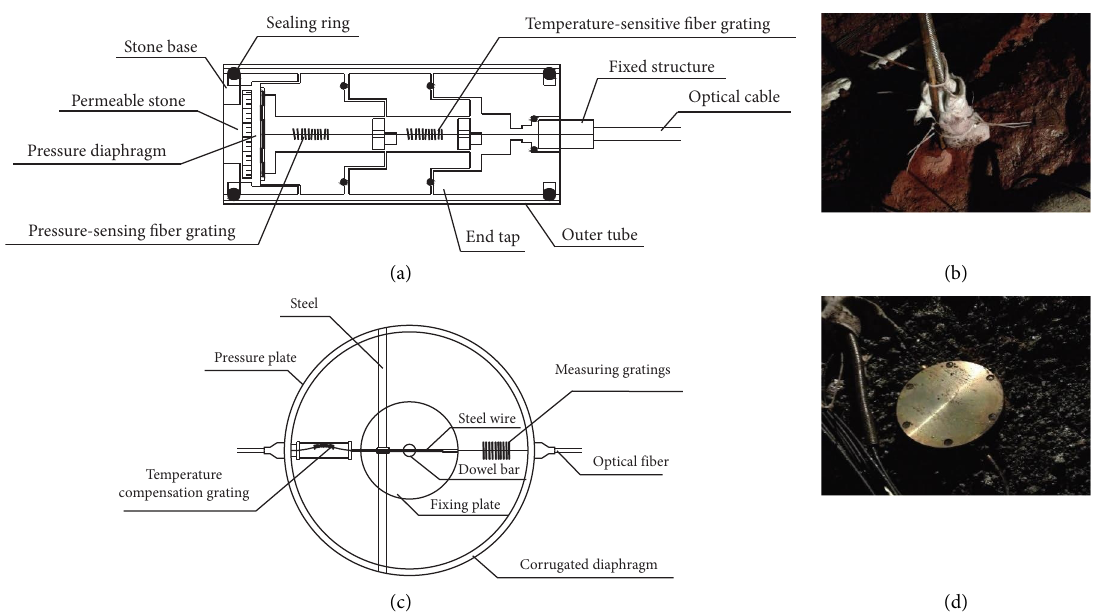
Figure 5: Schematic diagram of the installation of fber grating water-earth pressures sensor: (a) fber grating water pressure sensor; (b) fber grating water pressure sensor; (c) fber grating earth pressure; (d) fber grating earth